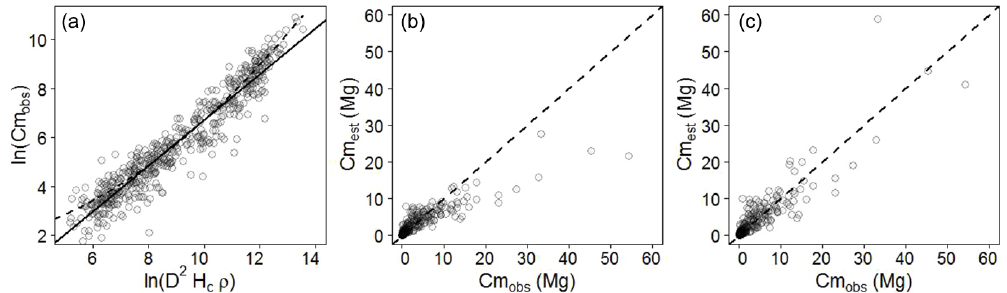
Figure 2. Panel (a) : observed crown mass vs. the compound variable D 2 × Hc × ρ (in log scale), displaying a slightly concave relationship. The crown mass sub-model sm 1 does not capture this effect (model fit represented with a full line in a ), resulting in biased model predictions (b) , whereas sub-model sm 3 does not present this error pattern (model fit represented as a dashed line in (a) ; observed crown mass against model predictions in c ). Models were fitted to Data CM2 (crown mass